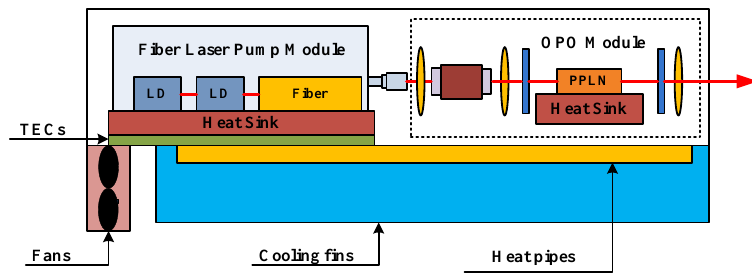
Figure 3. Schematic diagram of the laser and thermal control system.